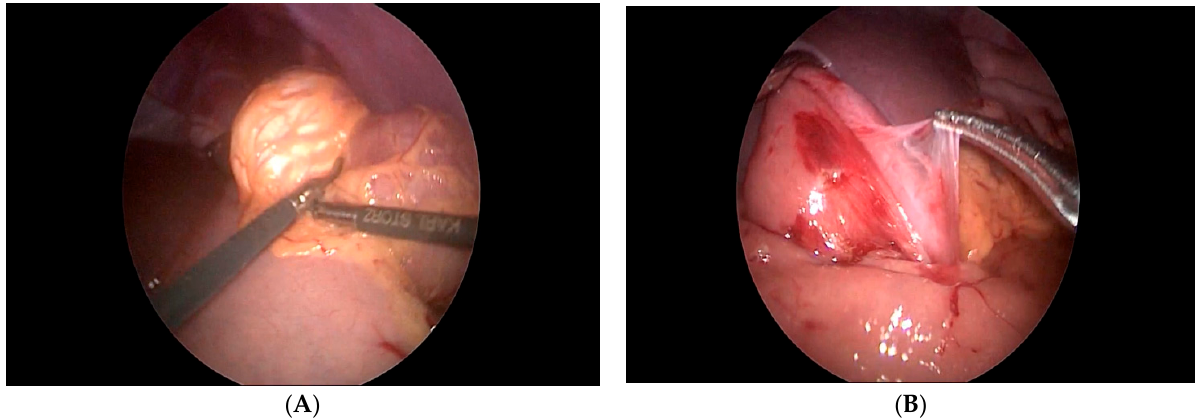
Figure 3. ( A ) Endoscopic navigation by transillumination of the duodenum and jejunum, ( B ) Cattell–Braasch maneuver.